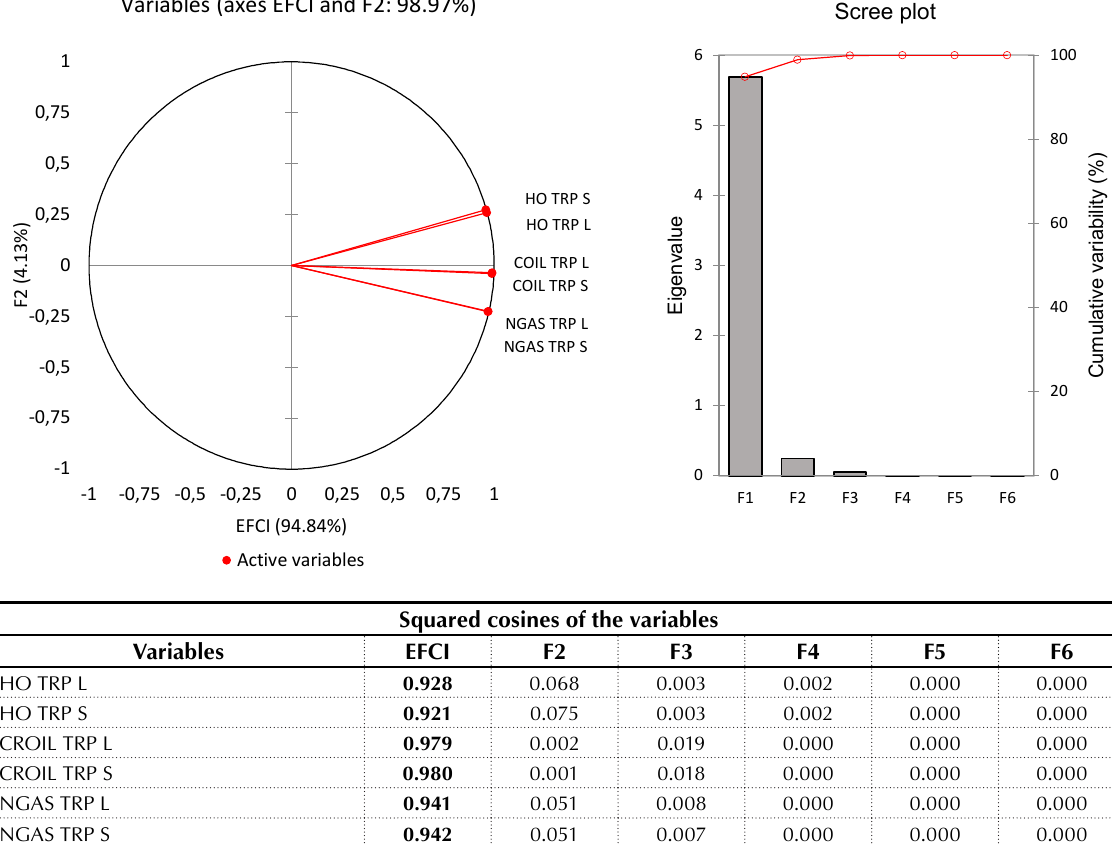
Figure 2. Principal component